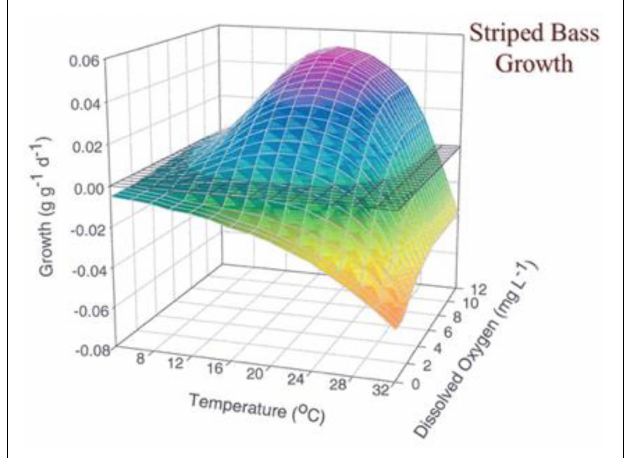
FIGURE 3 | The relationships between striped bass growth rate, temperature, and dissolved oxygen from Brandt et al. (2009).